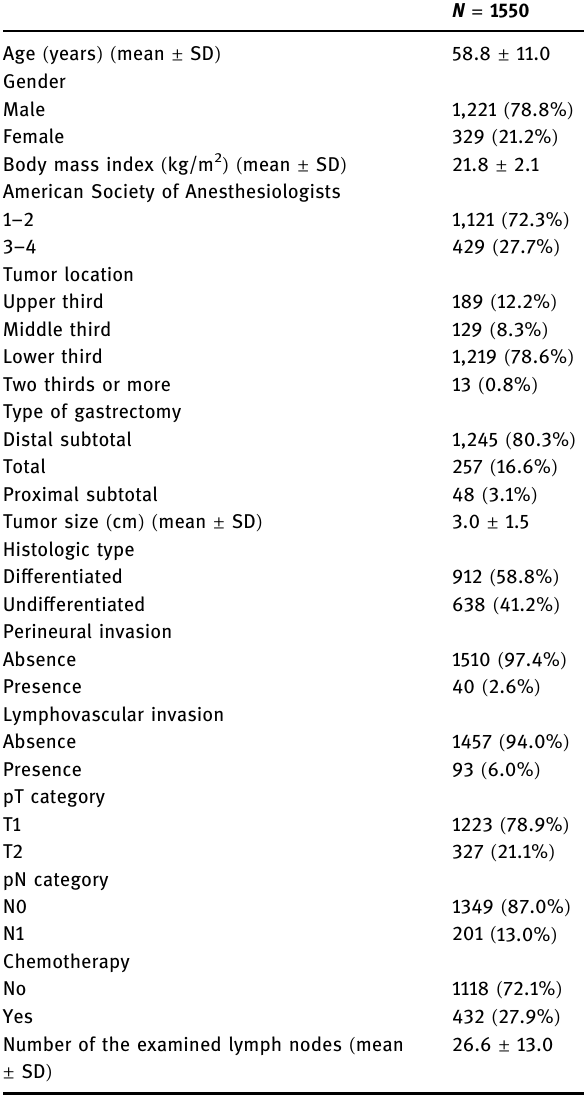
Table 1: Baseline clinicopathological characteristics of patients with stage I